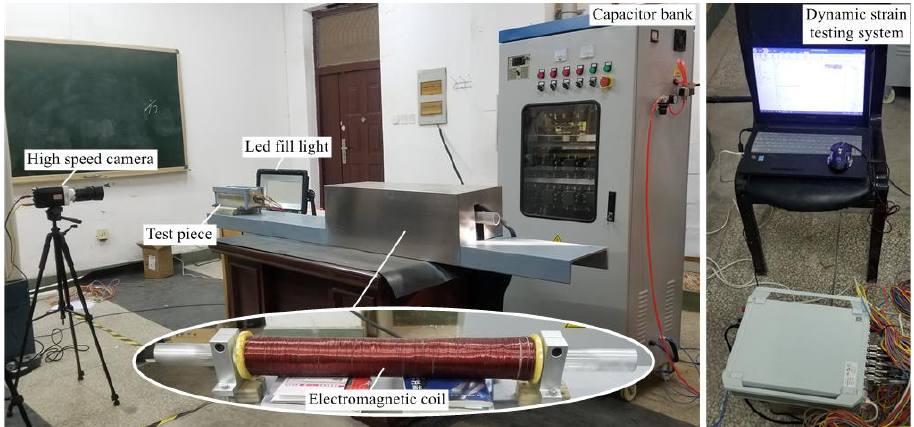
Figure 3. Electromagnetic impact device.